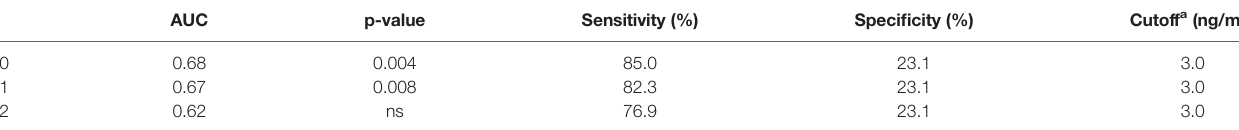
TABLE 5 | Area under the receiver operating characteristics curve and optimal cutoff value of HMGB1.